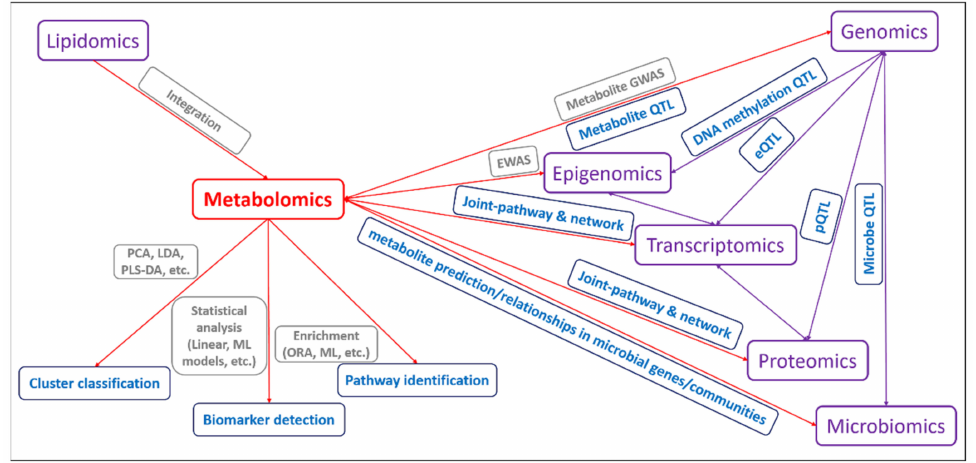
Figure 3. Metabolomics analysis workflow and the integrated analysis with other omics data in